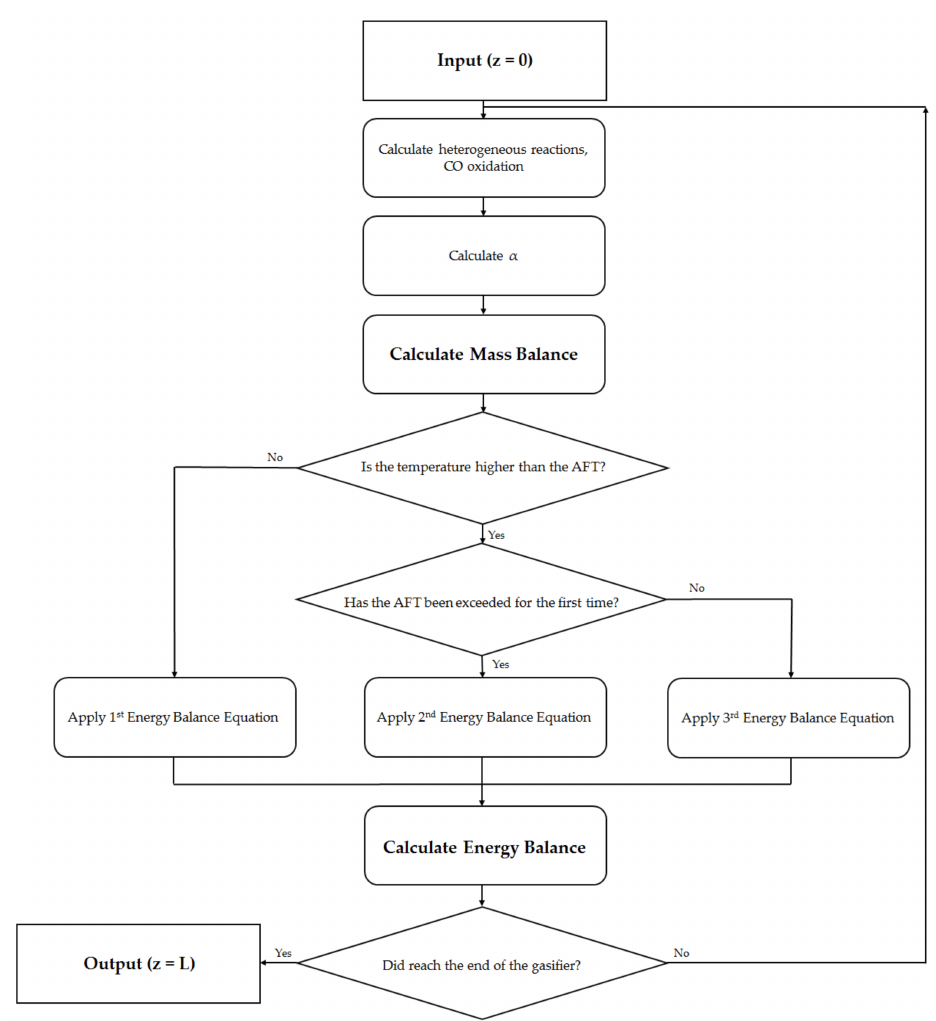
Figure 2. Algorithm that includes the melting of